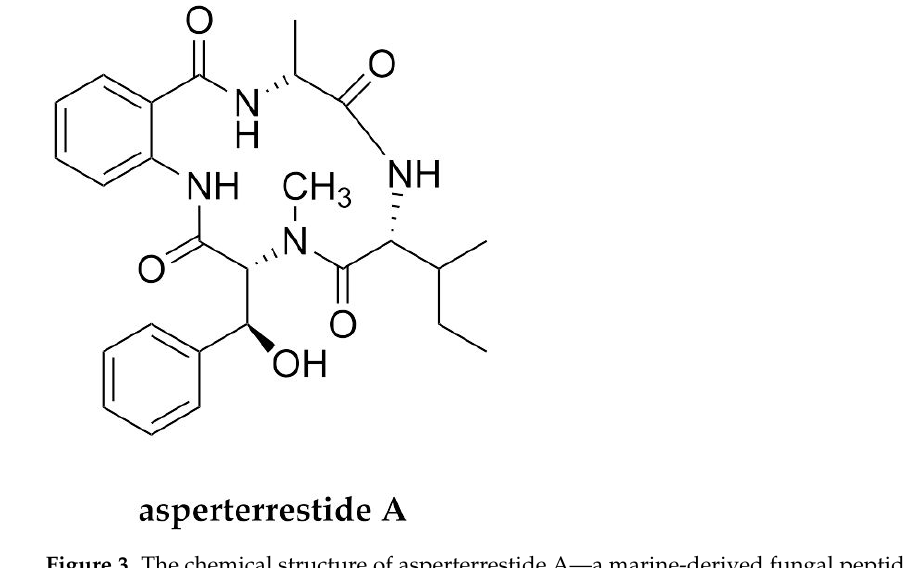
Figure 3. The chemical structure of asperterrestide A—a marine-derived fungal peptide possessing inhibitory effects on influenza viruses.